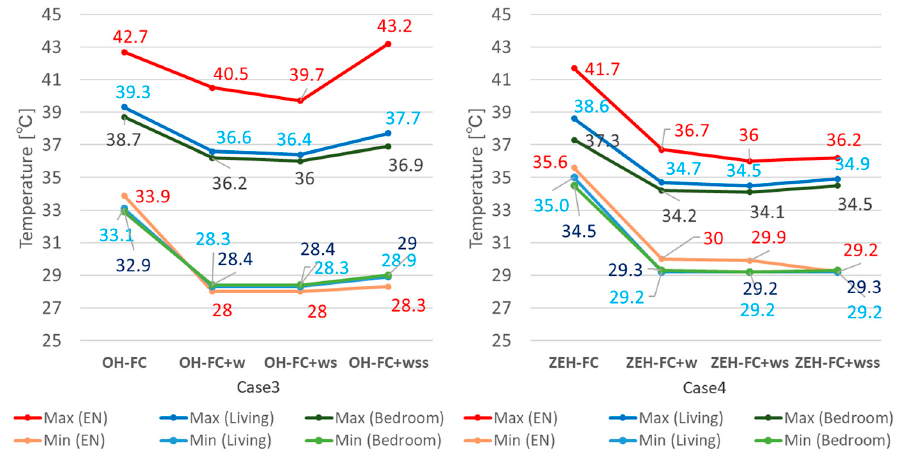
Figure 8. Max and Min temperatures depending on fitting adjustments (left: OH, right: ZEH).